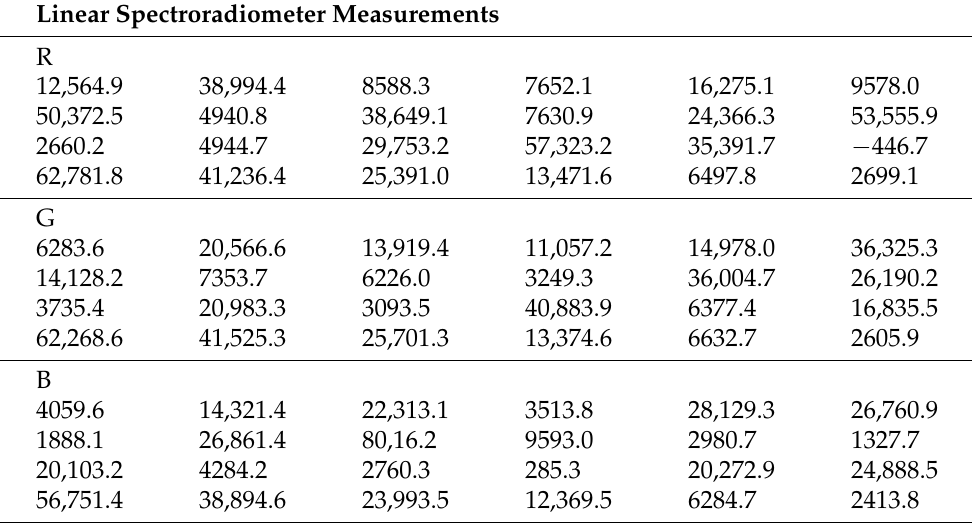
Table A2. Linear spectroradiometer measurement scaled to be comparable with the X-Rite color target values for each channel R, G, and B.